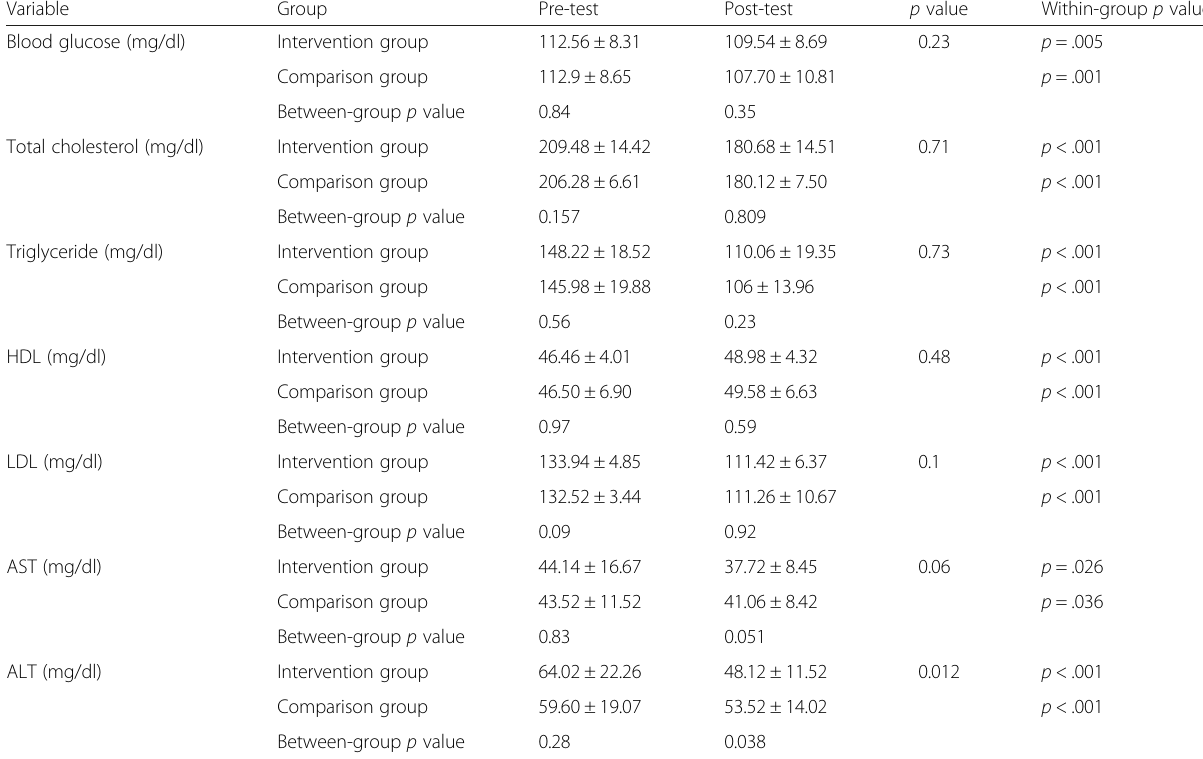
Table 3 Comparison of laboratory parameters between treatment groups during the study